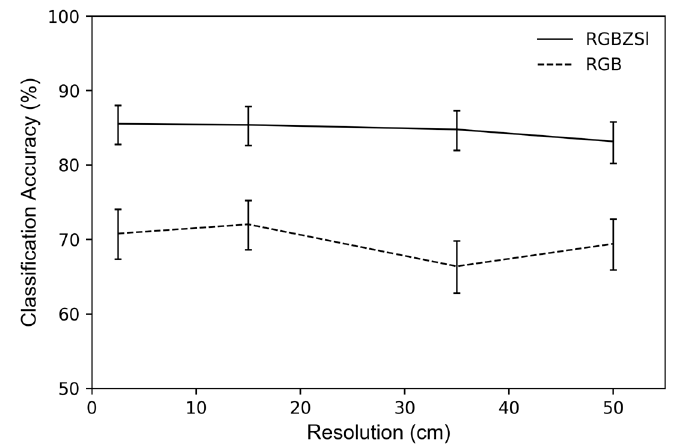
Figure 9. Overall classification accuracy plotted against input imagery resolution for classifications using visual (RGB; dashed line) and visual and topographic (RGBZSl; solid line) data. Vertical bars indicate 95% confidence interval. Note that y-axis values begin at 50.